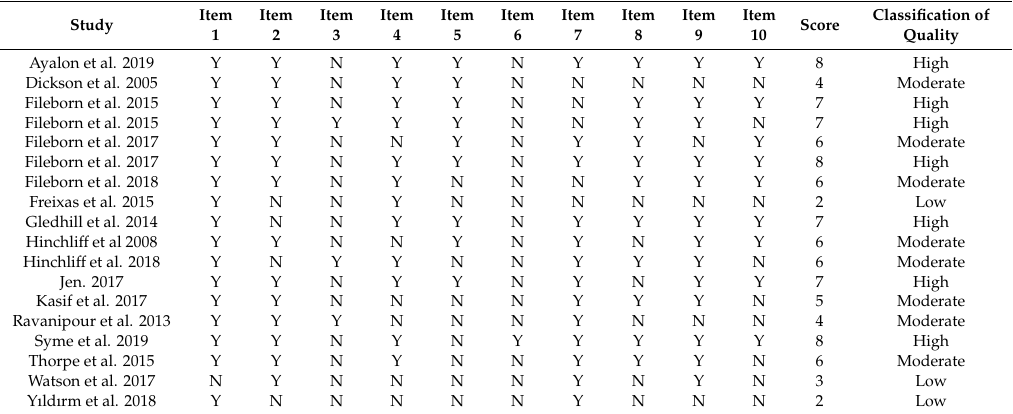
Table 4. CASP (Critical Appraisal Skills Programme) qualitative checklist scores for the methodological quality assessment of the qualitative studies included.